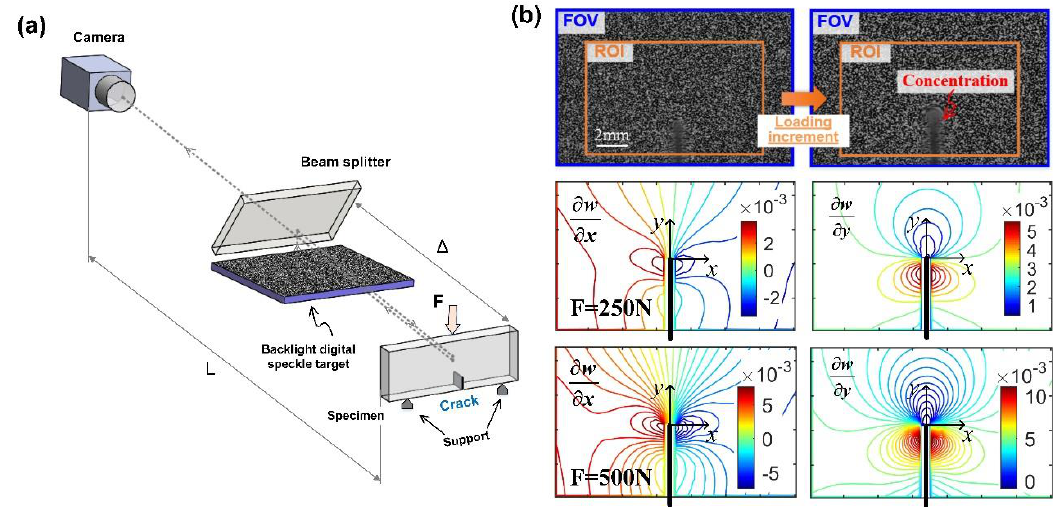
Figure 5. Experimental setup of enhanced r -DGS and its measurement results. ( a ) Experimental setup; ( b ) measured slope fields under uniaxial load of 250 and 500 N.